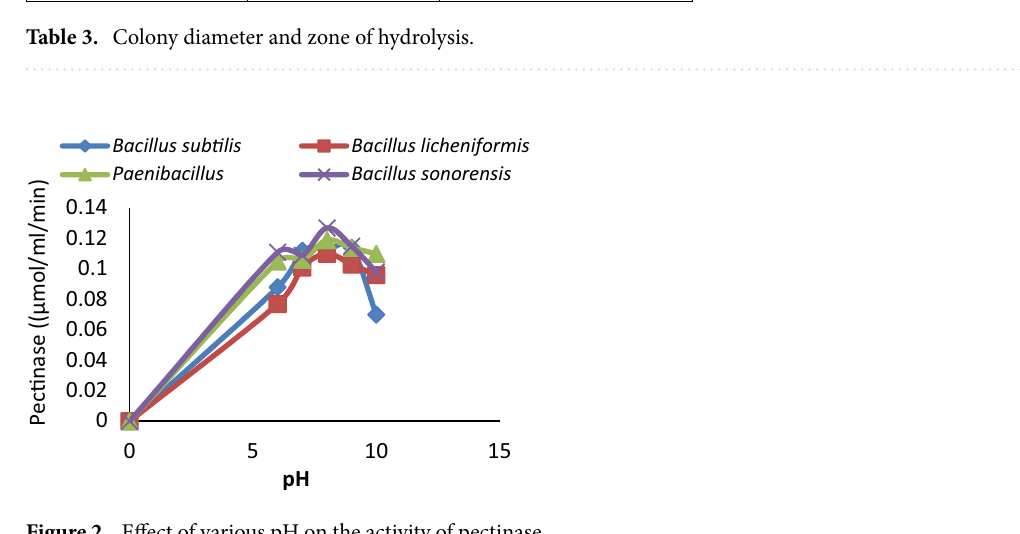
Figure 2. Effect of various pH on the activity of